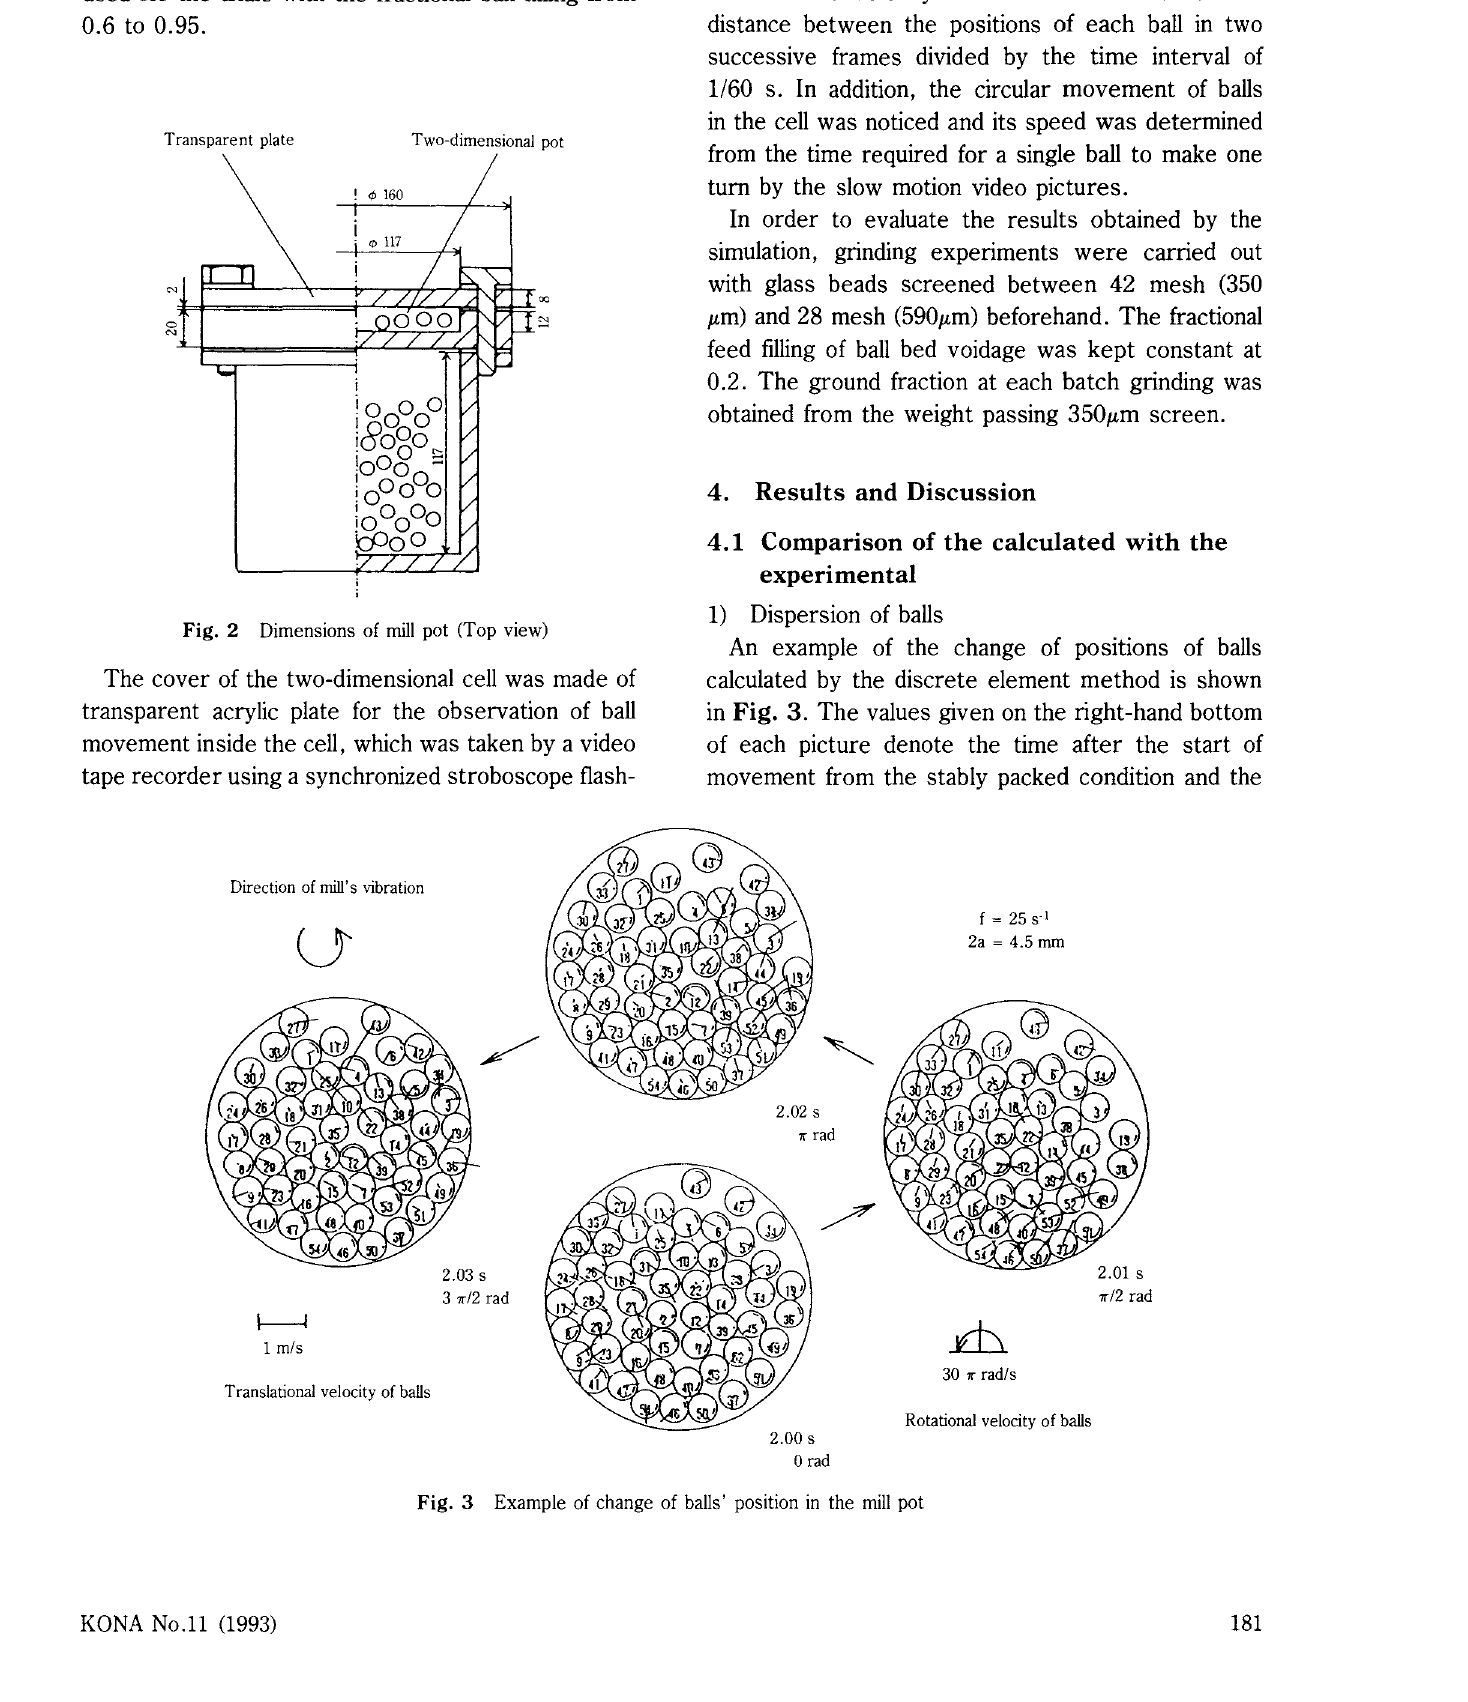
Fig. 3 Example of change of balls' position in the mill